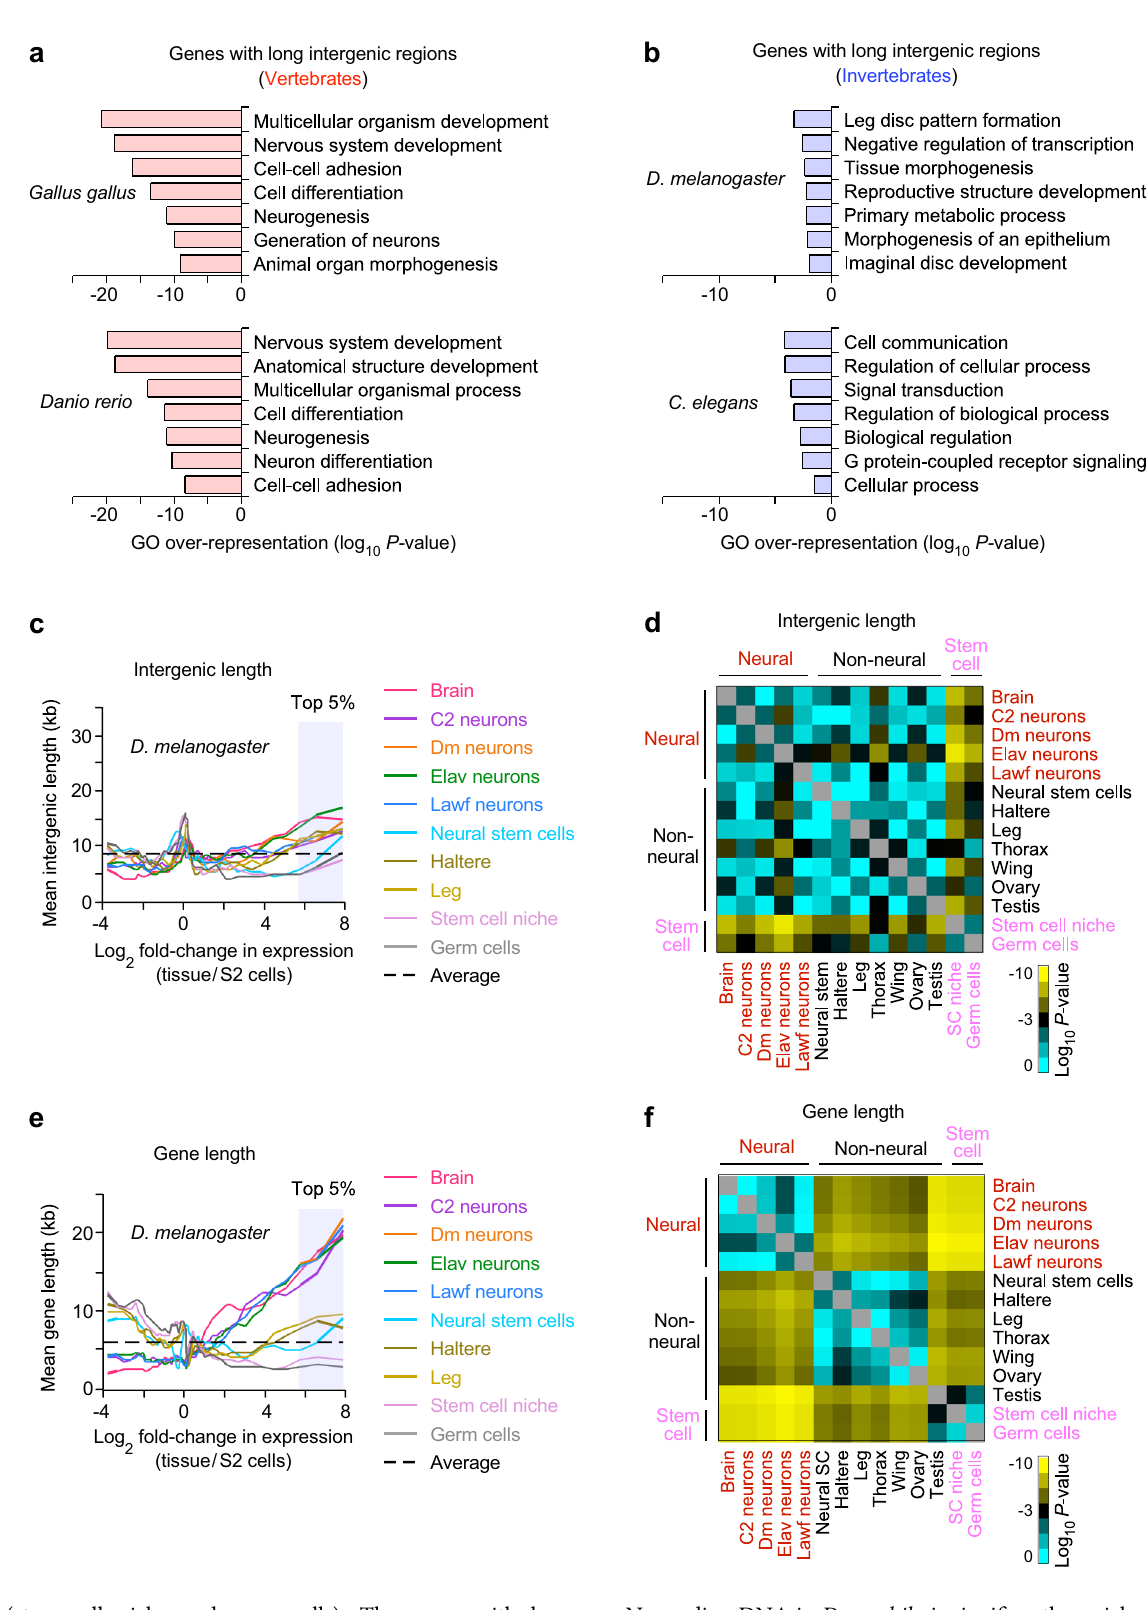
cells (stem cell niche and germ cells). The genes with long intergenic regions were enriched with gene annotations for tissue patterning and morphogenesis (Fig. 8b). Our observations are corroborated by the previous fi nding that developmentally regulated genes with regulatory complexity are fl anked by longer intergenic regions than functionally simple genes in Drosophila 8 .